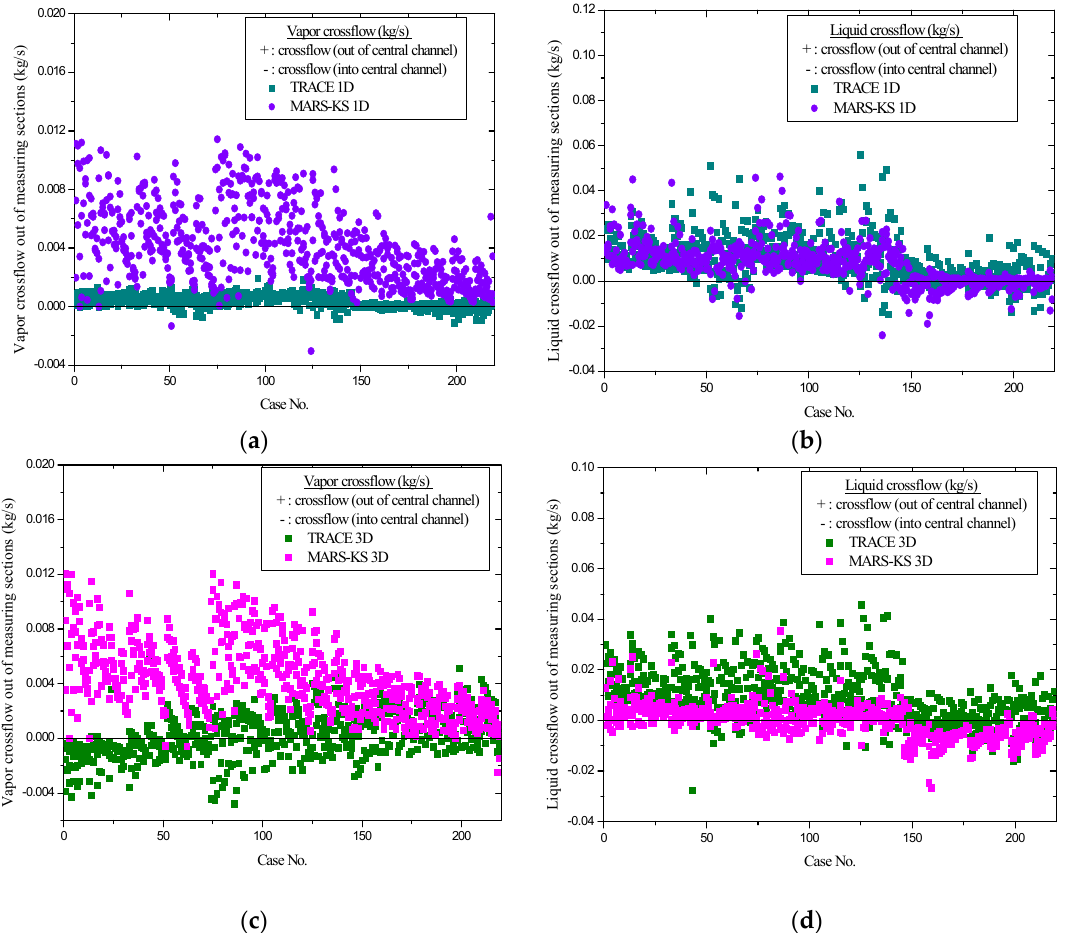
Figure 8. Code comparisons: ( a ) 1D vapor crossflow; ( b ) 1D liquid crossflow; ( c ) 3D vapor crossflow; ( d ) 3D liquid crossflow.